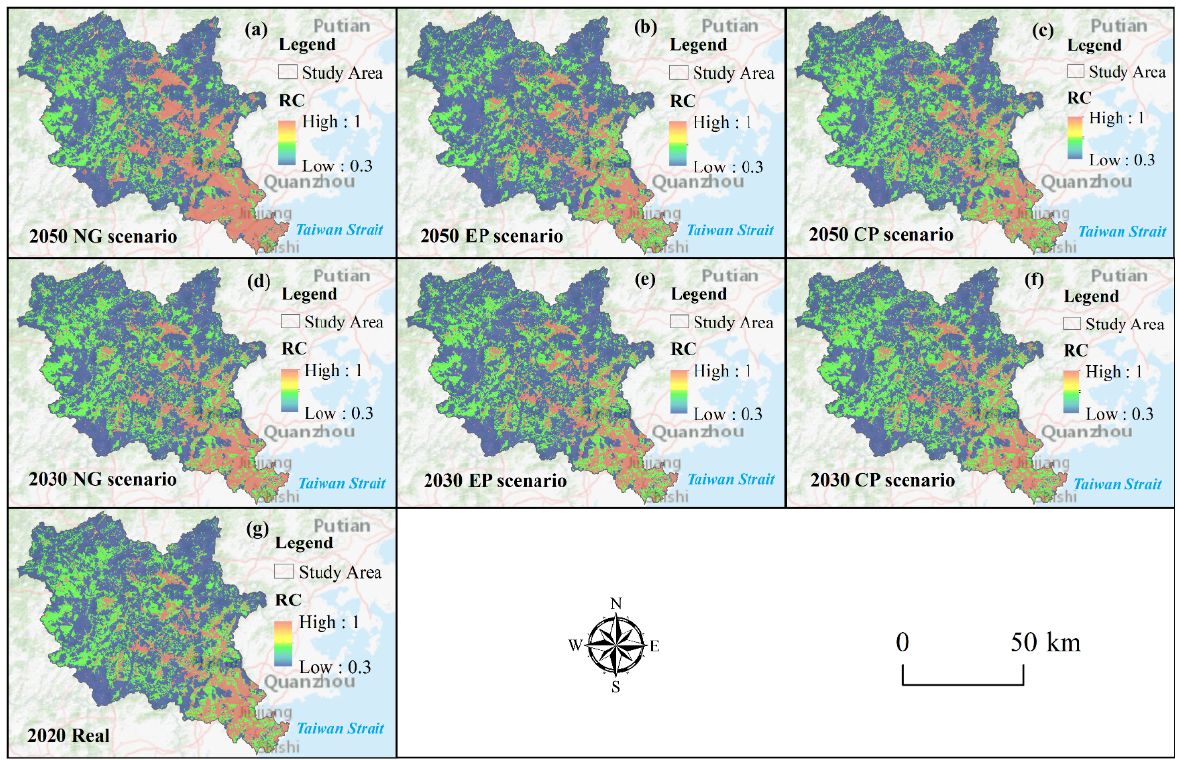
POP is the population, whose unit is set as million people; GBR is the general budget revenue, whose unit is set as billion yuan.